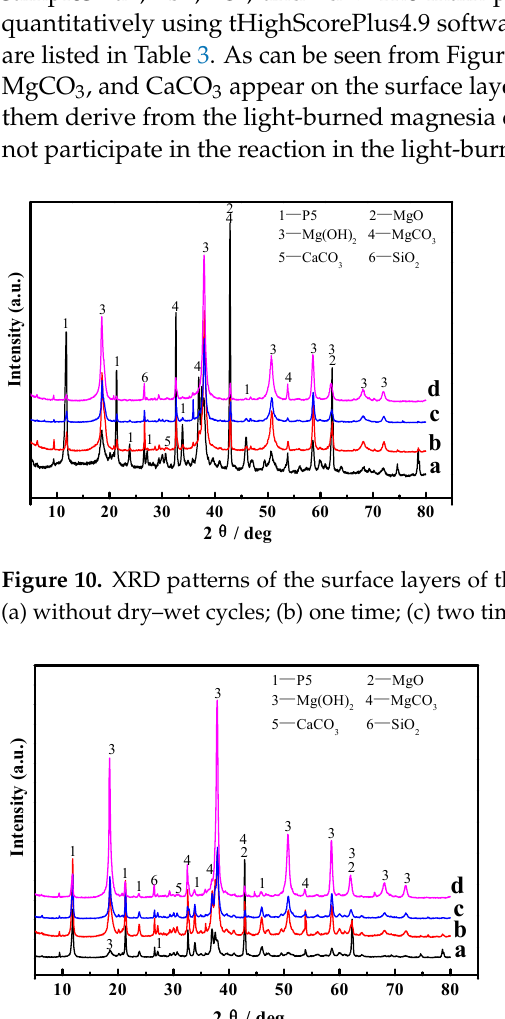
Figure 11. XRD patterns of the inner cores of the MOC samples after different dry–wet cycles: (a) without dry–wet cycles; (b) one time; (c) two times; (d) three times. Table 3. Content of the main phase for the surface layers and inner cores of the MOC samples after different dry–wet cycles: (a) without dry–wet cycles; (b) one time; (c) two times; (d) three times. Sampling Points Samples